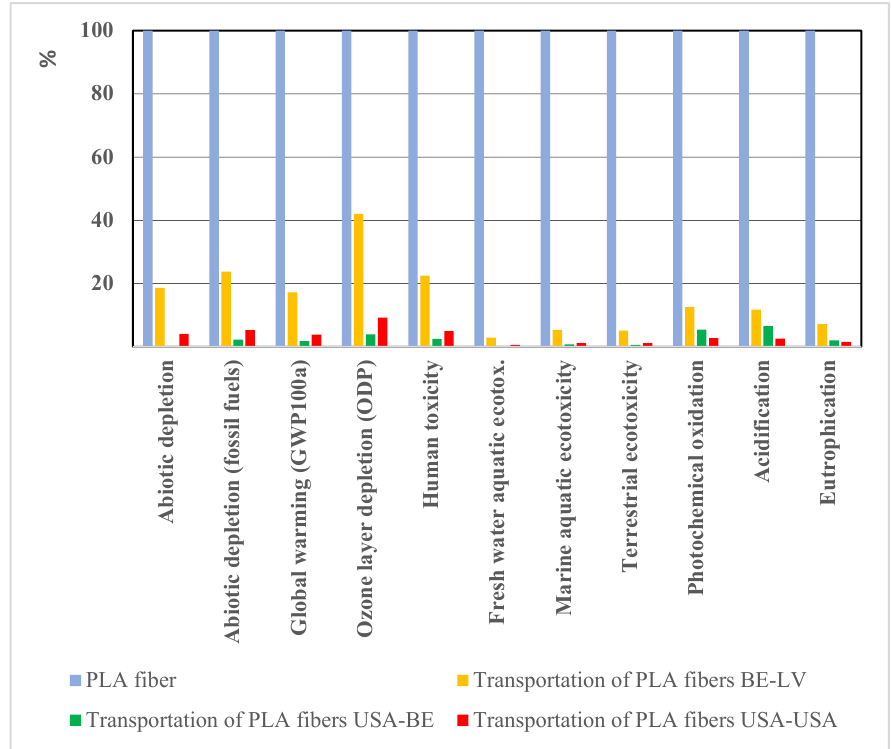
Figure 6. Environmental impact of production and transportation of polylactide fibers.